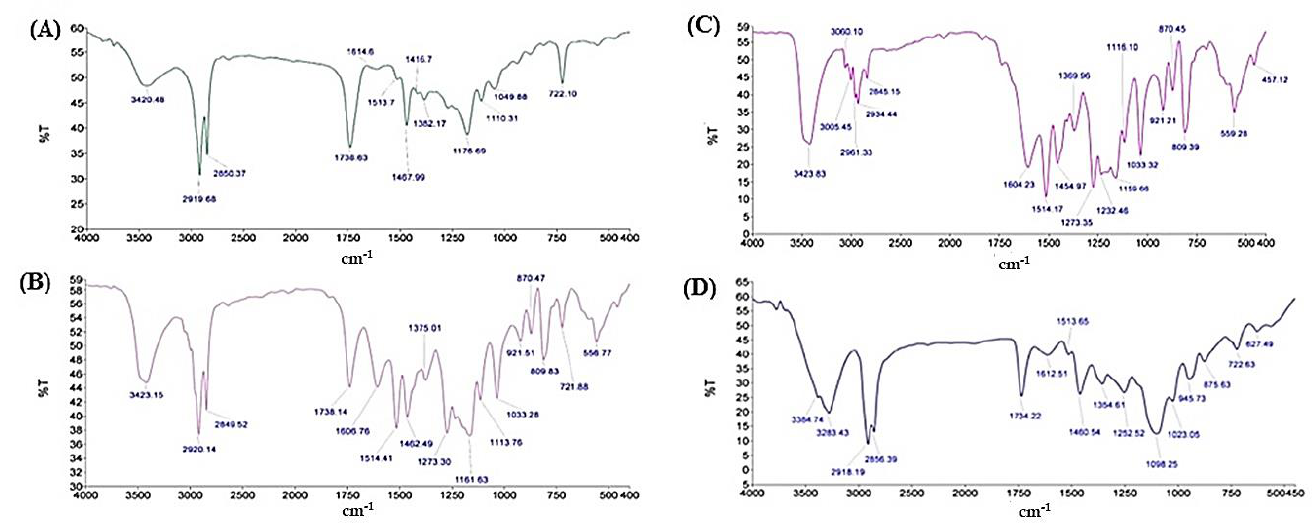
Figure 2. FTIR spectra of ( A ) pure THC ( B ) pure Compritol ® 888 ATO ( C ) physical mixture of THC and Compritol ® 888 ATO ( D ) THC-SLN dispersion.